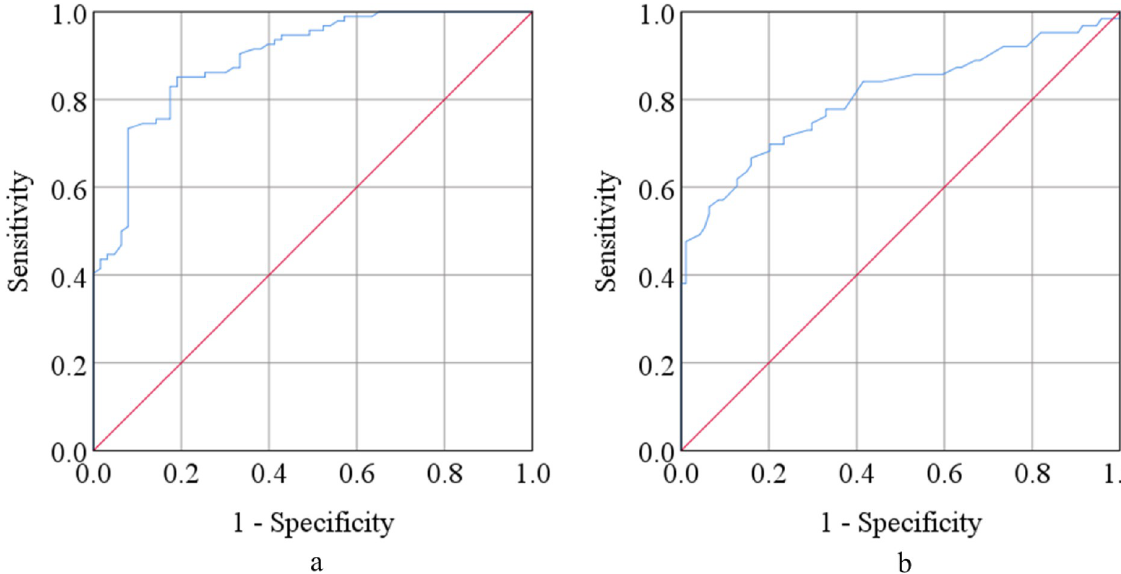
Fig 3. Receiver operating characteristic (ROC) curves of serum adiponectin (a) and interleukin-8 (b) among the study population.